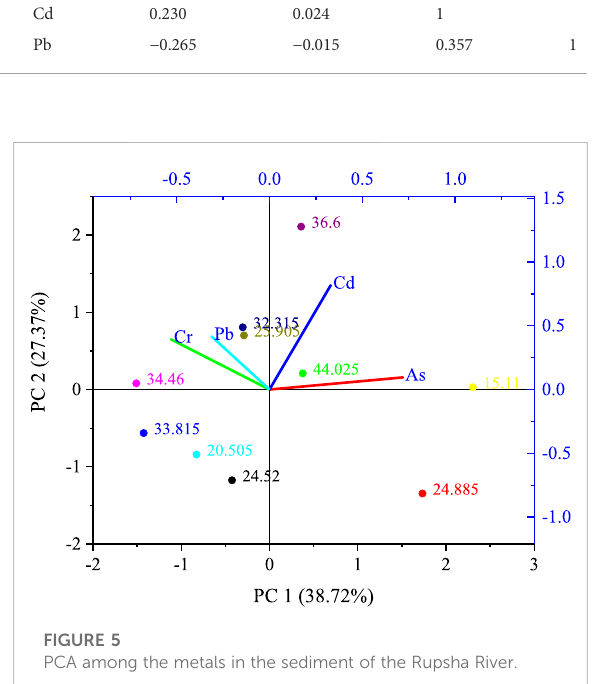
FIGURE 5 PCA among the metals in the sediment of the Rupsha